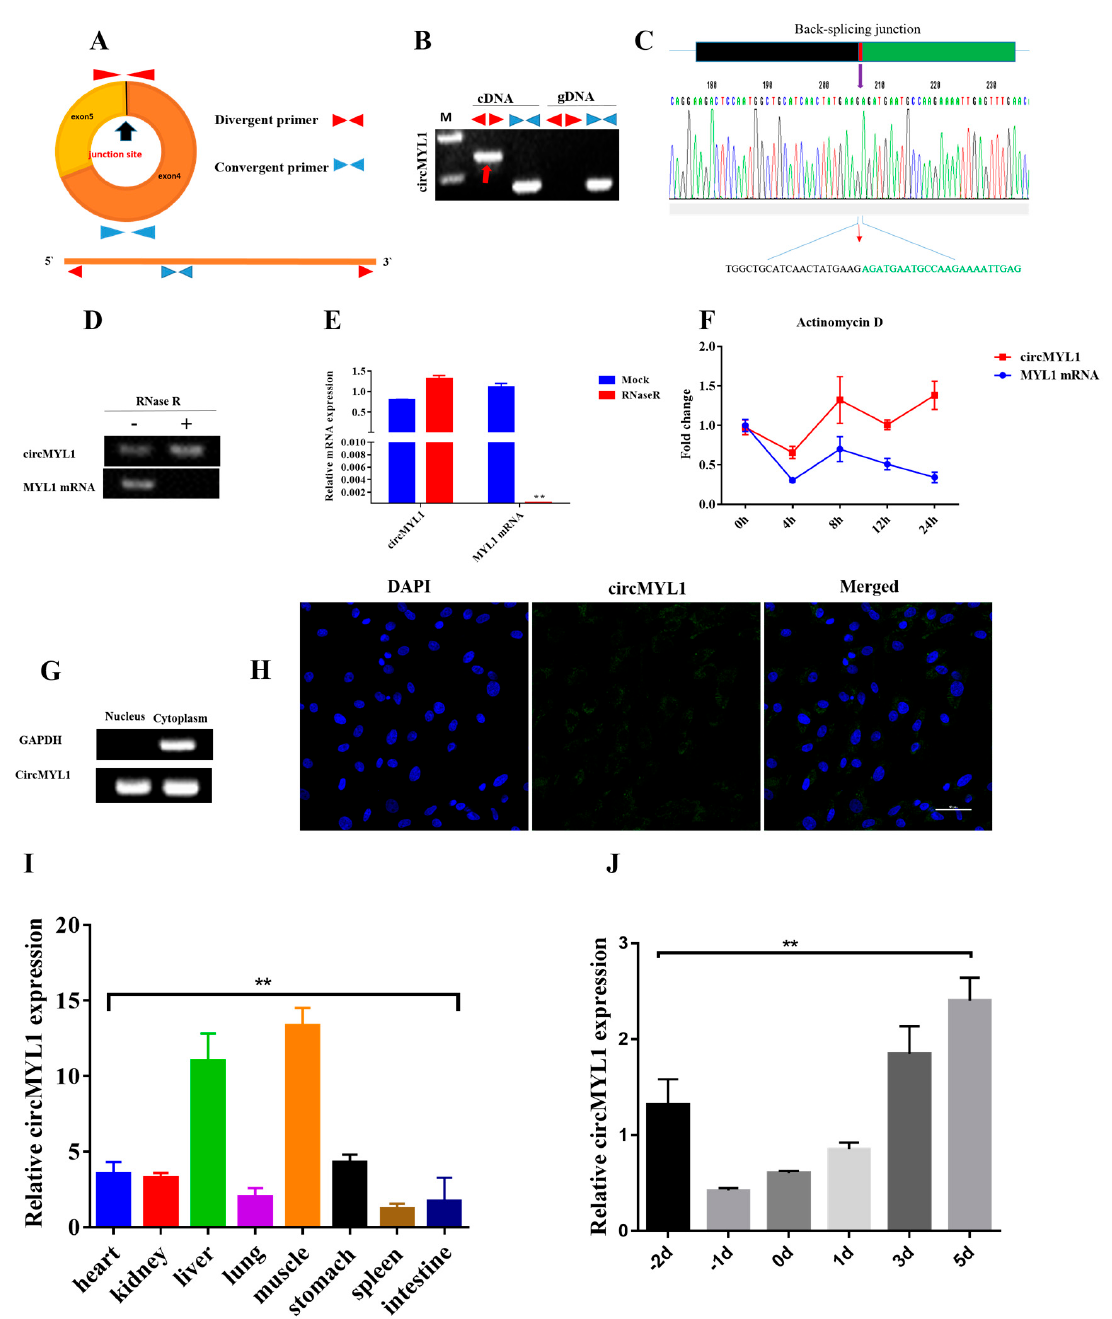
Figure 1. Characterization of circMYL1 ( A ) Schematic diagram showing the design of the circMYL1 primers. ( B ) The divergent primers and convergent primers in cDNA and gDNA samples. ( C ) Sanger sequencing confirmed the circMYL1 sequence of the back-splicing junction. ( D ) RNase R verified the existence of circMYL1. ( E ) qRT-PCR demonstrated the relative expression of circMYL1 and MYL1 mRNA in myoblasts treated with RNase R ( F ) qRT-PCR detected the